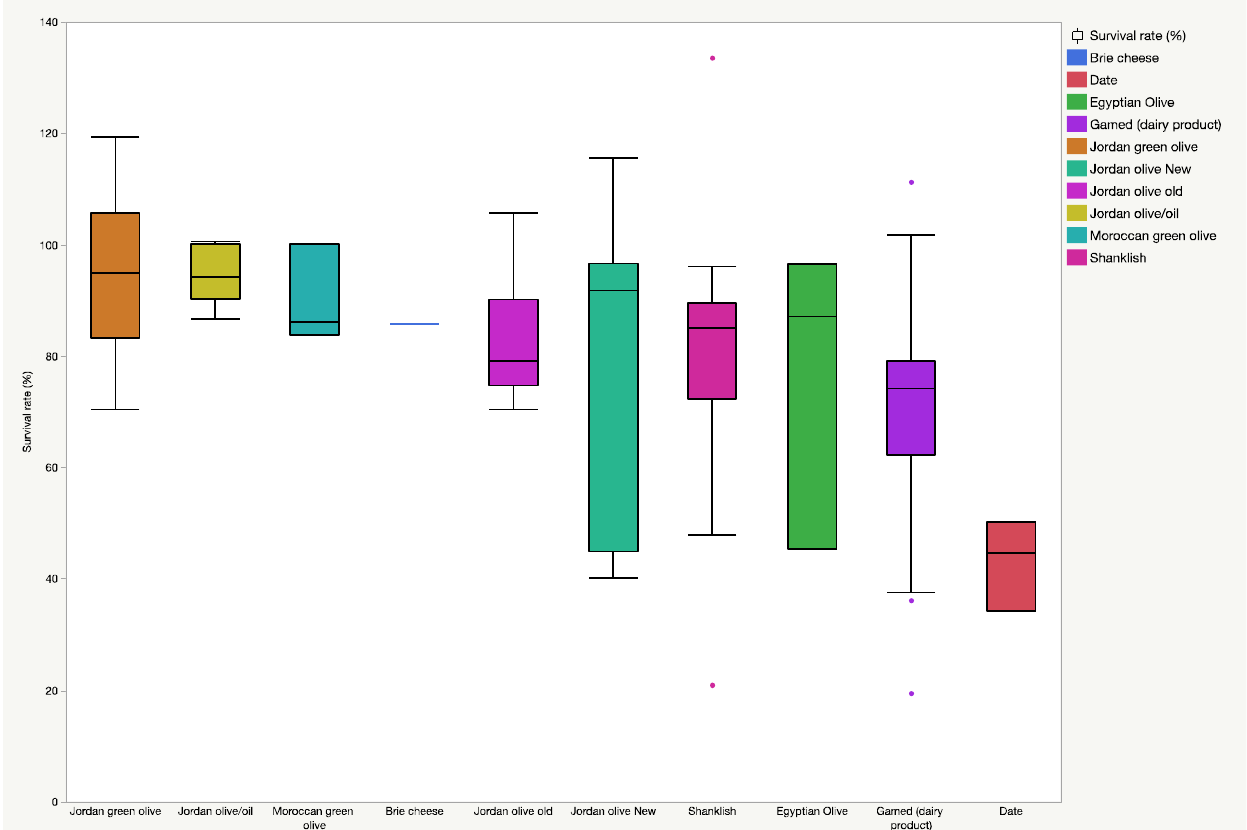
Figure 1. Boxplot summarizing the survival rate (%) of the 105 yeast isolates under pH 2.5 for 2 h at 37 °C. Bullets represent outliners. 37 ◦ C. Bullets represent